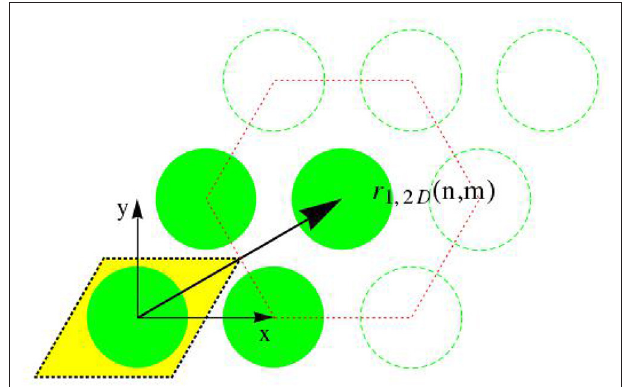
FIGURE 3 | Illustration of a hexagonal lattice and unit